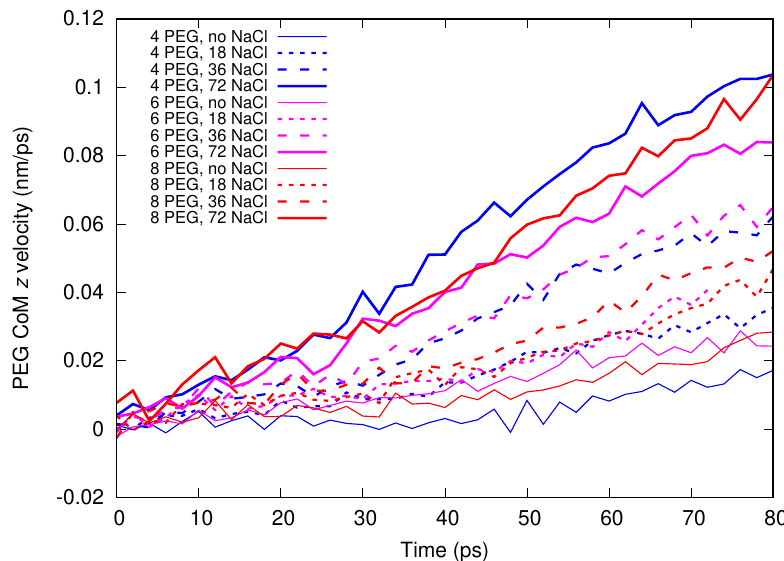
Figure 19. The z -component of the velocity of PEG’s center of mass as a function of production time for samples with 10.55-kDa PEG chains under 1.5 V/nm. Curves correspond to different numbers of PEG chains and NaCl ion pairs, see the legend. Plotted with gnuplot [56].